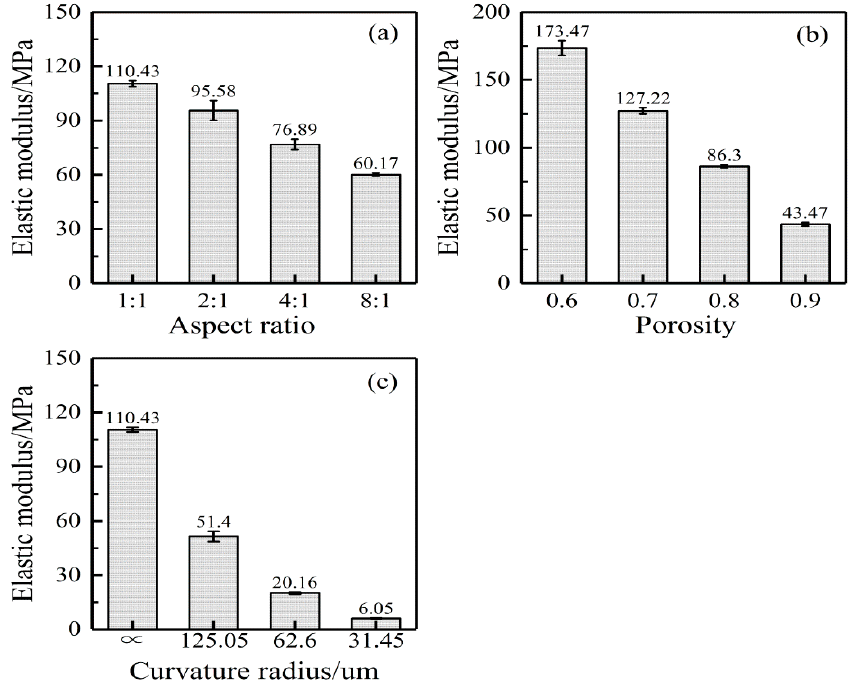
Figure 10. Effect of the structural parameters on the elastic modulus of nanofibrous mats. ( a ) ratio; ( b ) porosity; ( c ) fiber length-width ratio; ( b ) porosity; ( c ) fiber curvature.